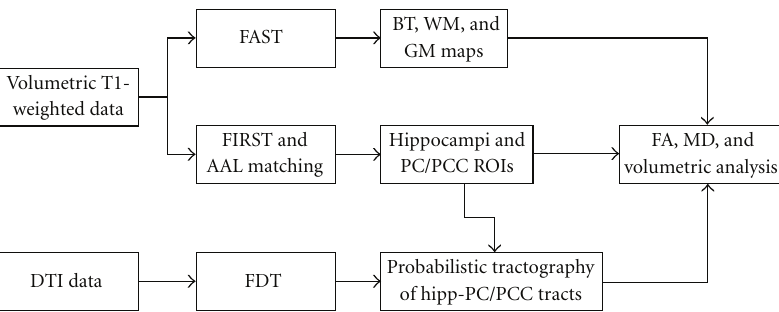
Figure 1: Study design schematic. DTI data were preprocessed by FDT (FSL) to obtain MD and FA maps. Structural T1 data were corrected in intensity by FreeSurfer and segmented in brain, grey and white matter volumes by FAST (FSL). Hippocampi and PC/PCC were segmented automatically by FIRST and AAL template registration and then registered on DTI maps. Tracts connecting hippocampus to PC/PCC (hipp- PC/PCC) were identified by probabilistic tractography within FDT and then registered back on structural T1 data. Normalized volumes, MD, and FA values were obtained for GM, WM, hippocampi, PC/PCC, and hipp-PC/PCC tracts.